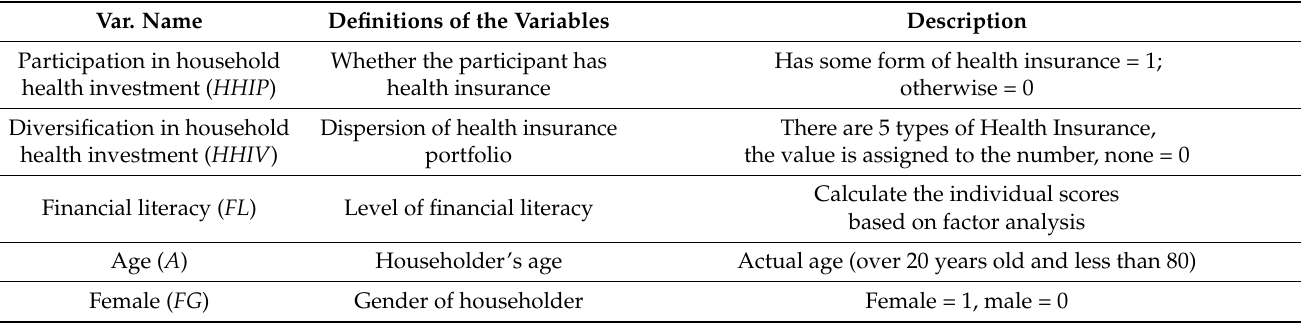
Table 3. Description of main